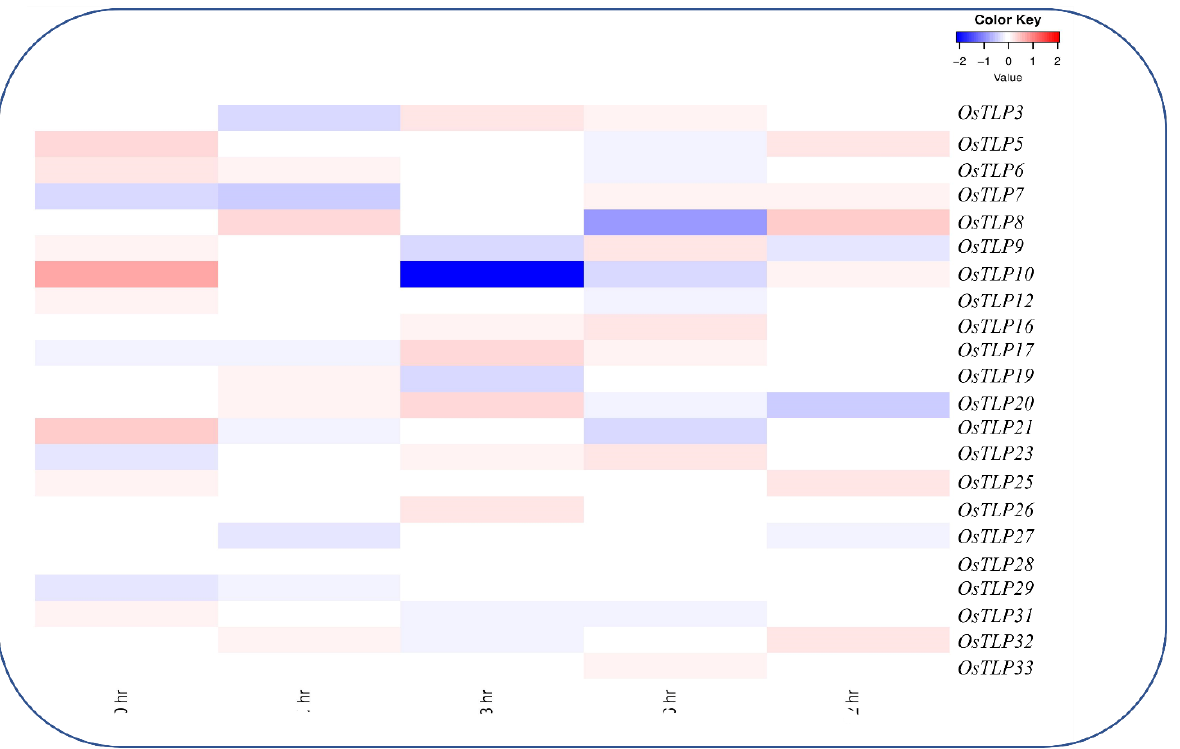
Figure 9. Heatmap of OsTLP genes representation under brassinosteroids. The log2 transformation method normalized and converted the RPKM values displayed.